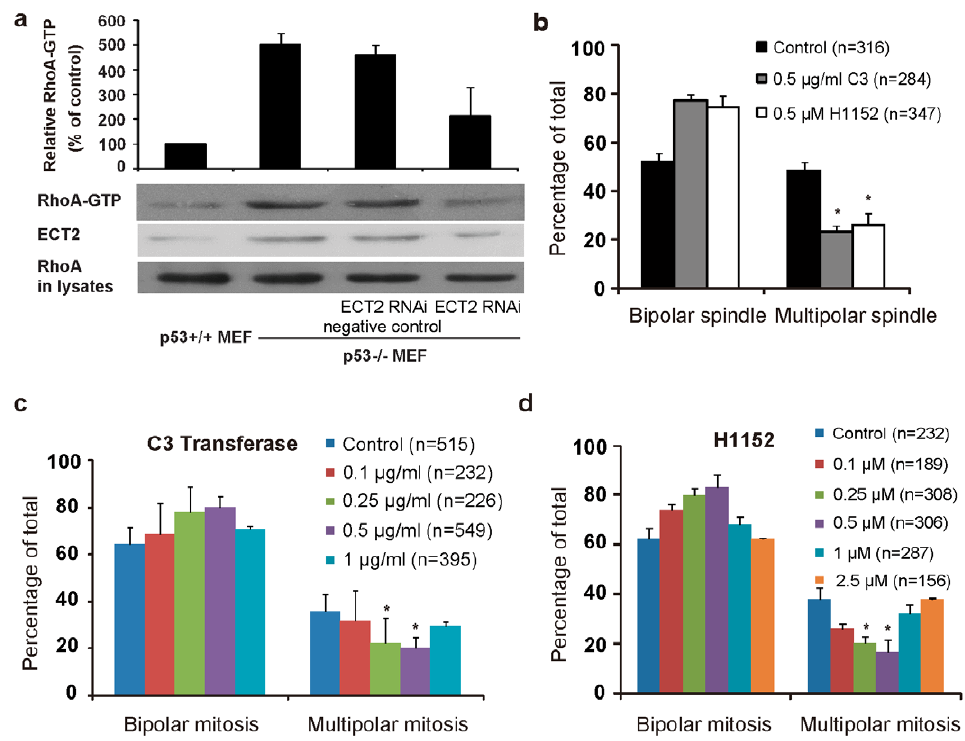
Figure 4. Over-activated RhoA contributes to multipolar spindle formation in p53 -/- tetraploid cells. (A) The endogenous RhoA activities (RhoA-GTP) in the p53 + / + and p53 -/- MEF cells were assayed after indicated treatment. The lysates were subject to GST-Rhotekin pull-down analysis. The amount of RhoA-GTP was detected by Western blotting of the glutathione-agarose coprecipitated with anti-RhoA antibody and was normalized to that of RhoA in wild-type MEFs. The results are shown as the mean 6 s.d. of three experiments. (B) The frequency of multipolar spindle at metaphase in MEF cells with extra centrosomes reduced after treatment of 0.5 m g/ml C3 transferase or 0.5 m M H1152 for 8 h, respectively (*P , 0.001, 2 6 2 x 2 test). (C) Concentration dependent suppression of multipolar mitosis in tetraploid p53 -/- MEF cells by C3 transferase, a cell permeable RhoA inhibitor. (D) Concentration dependent suppression of multipolar mitosis in tetraploid p53 -/- MEF cells by H1152, a cell permeable ROCK inhibitor. (C,D) Cells were induced to tetraploid cells with 0.5 m g/ml Cyto-B for 12 h, then were released and incubated with the indicated concentrations of the inhibitors, tracked by live cell imaging for 40 h (*P , 0.001, 2 6 2 x 2 test). Error bars are standard deviation, from results of three independent experiments. n, the number of cells analyzed.